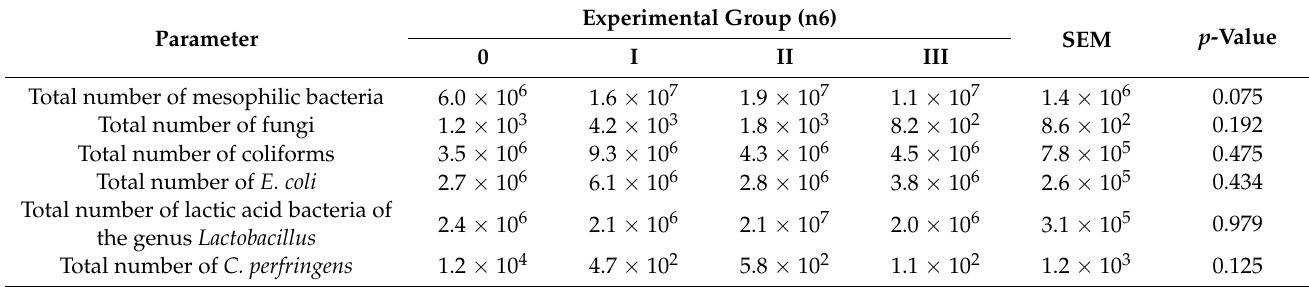
Table 5. Numbers of microorganisms in individual groups in the animal faeces